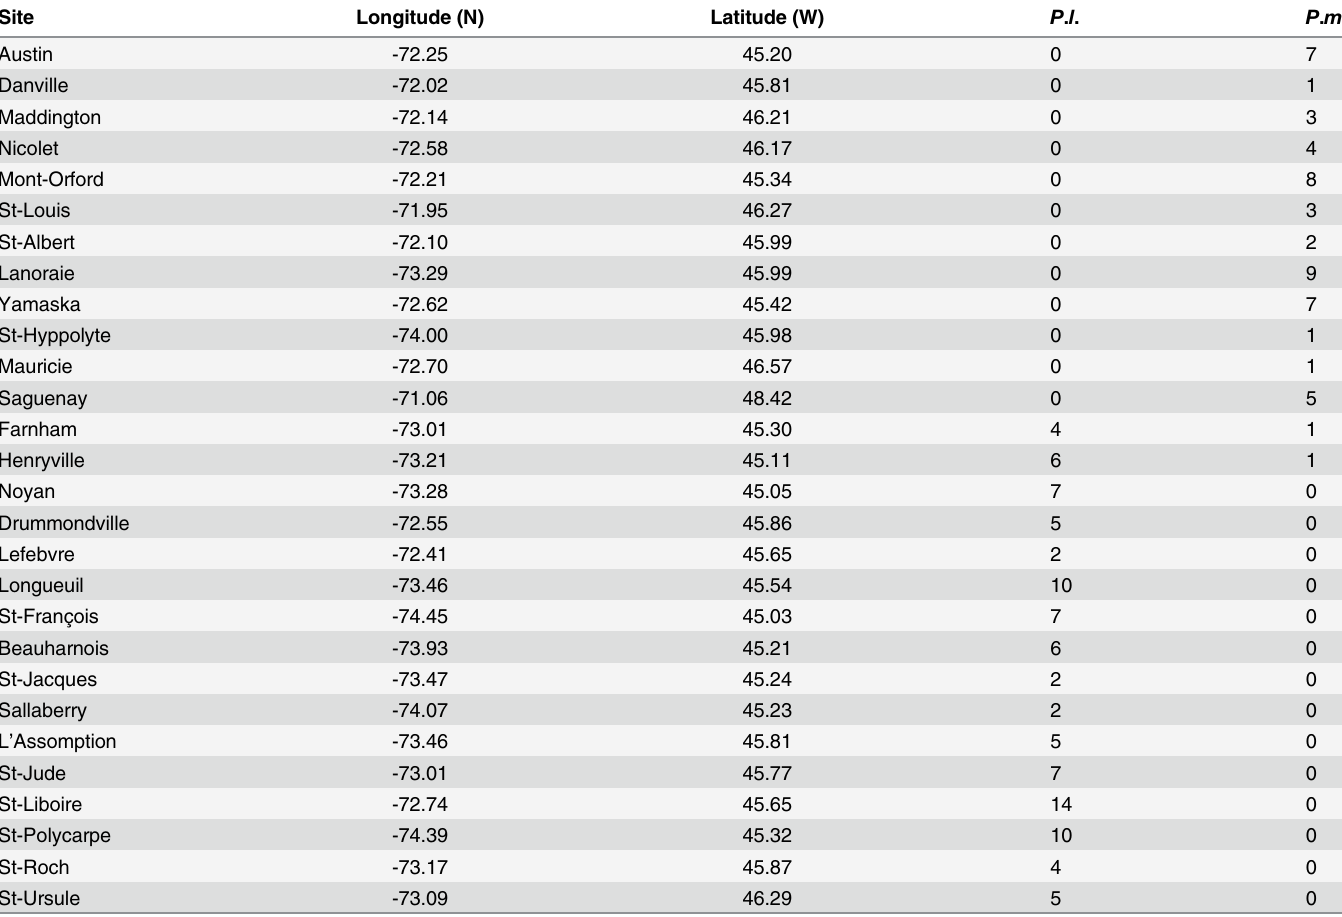
Table 1. Geographical coordinates of the sampling sites, and sample size for P . leucopus ( P . l .) and P . maniculatus ( P . m .).